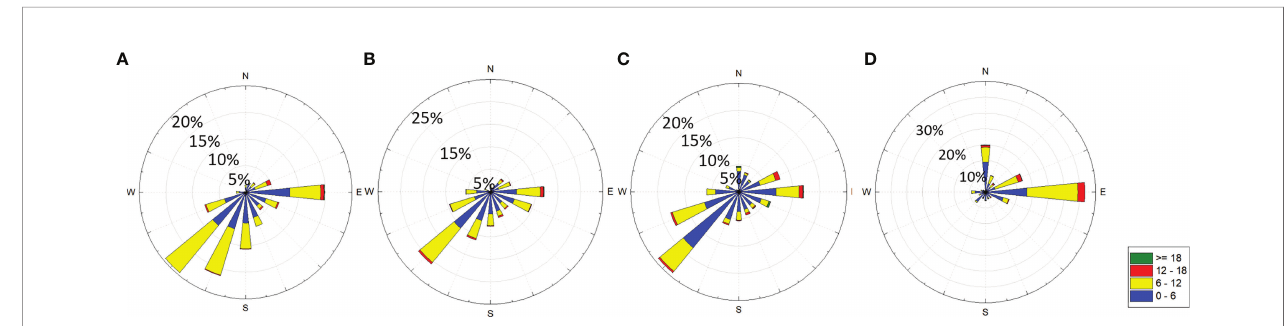
Figure 1 ) are obtained from the Hong Kong Observatory (HKO), and are assumed to represent the overall wind fi eld over southern waters of Hong Kong including station SM17, SM18 and SM19. Southwesterly winds are dominant in June, July and August due to the Southwest Monsoon while easterly winds induced by typhoons occurred occasionally. Wind speeds above 6m/s occur less frequently in August which makes the water column in August most vulnerable to episodic events of hypoxia. However, the transition stage of monsoon and the frequent typhoons coming from the open sea generates dominated easterly winds in September ( Figure 2 ). In general, wind direction, which is dominated by southwesterly monsoon winds during June, July and August, enable more eastward- directed plume propagation to the southern water of Hong Kong, which can enhance the water strati fi cation and weaken the upwelling, favoring in the formation of hypoxia. Easterly winds due to the typhoons and transition stage of monsoon push the river plume westward away from Hong Kong waters and enhance the vertical mixing, preventing the formation of hypoxia (Kuang et al., 2011). However, wind speed is